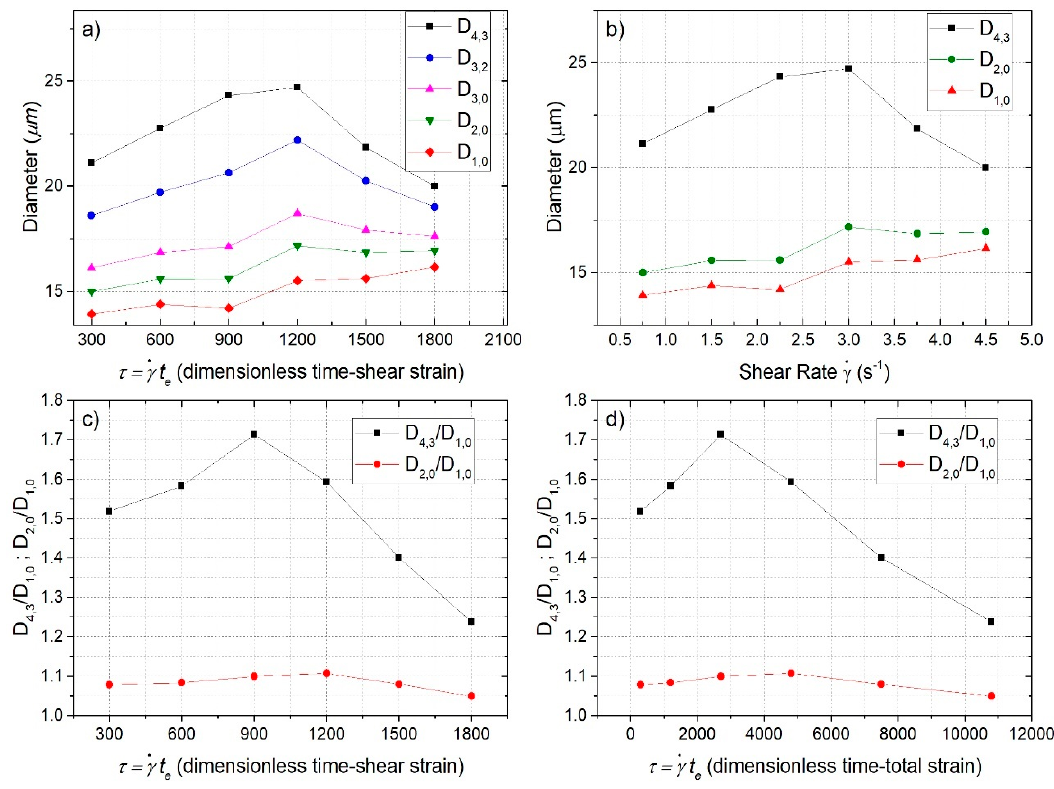
Figure 4. ( a ) Mean diameters of the distributions— D 1,0 up to D 4,3 —vs. the dimensionless time τ i incurred during each flow regime; ( b ) D 1,0 , D 2,0 , and D 4,3 vs. the applied shear rate during each regime; ( c , d ) are, respectively, the dimensionless normalized mean drop size vs dimensionless time in each cycle and for the total duration of the flow ∑ γ i t i